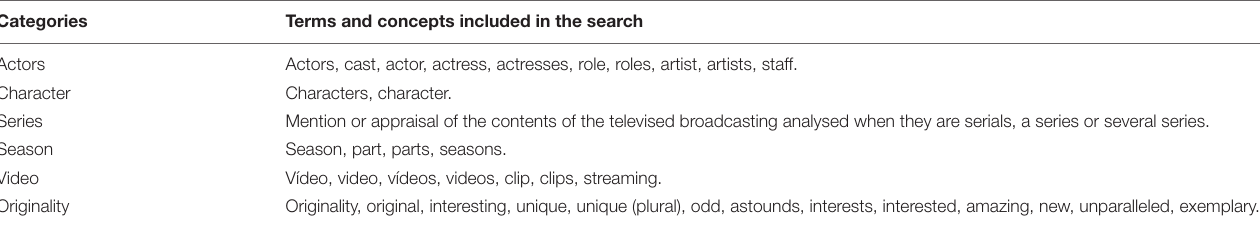
TABLE 8 | Analysis categories related to the series content and